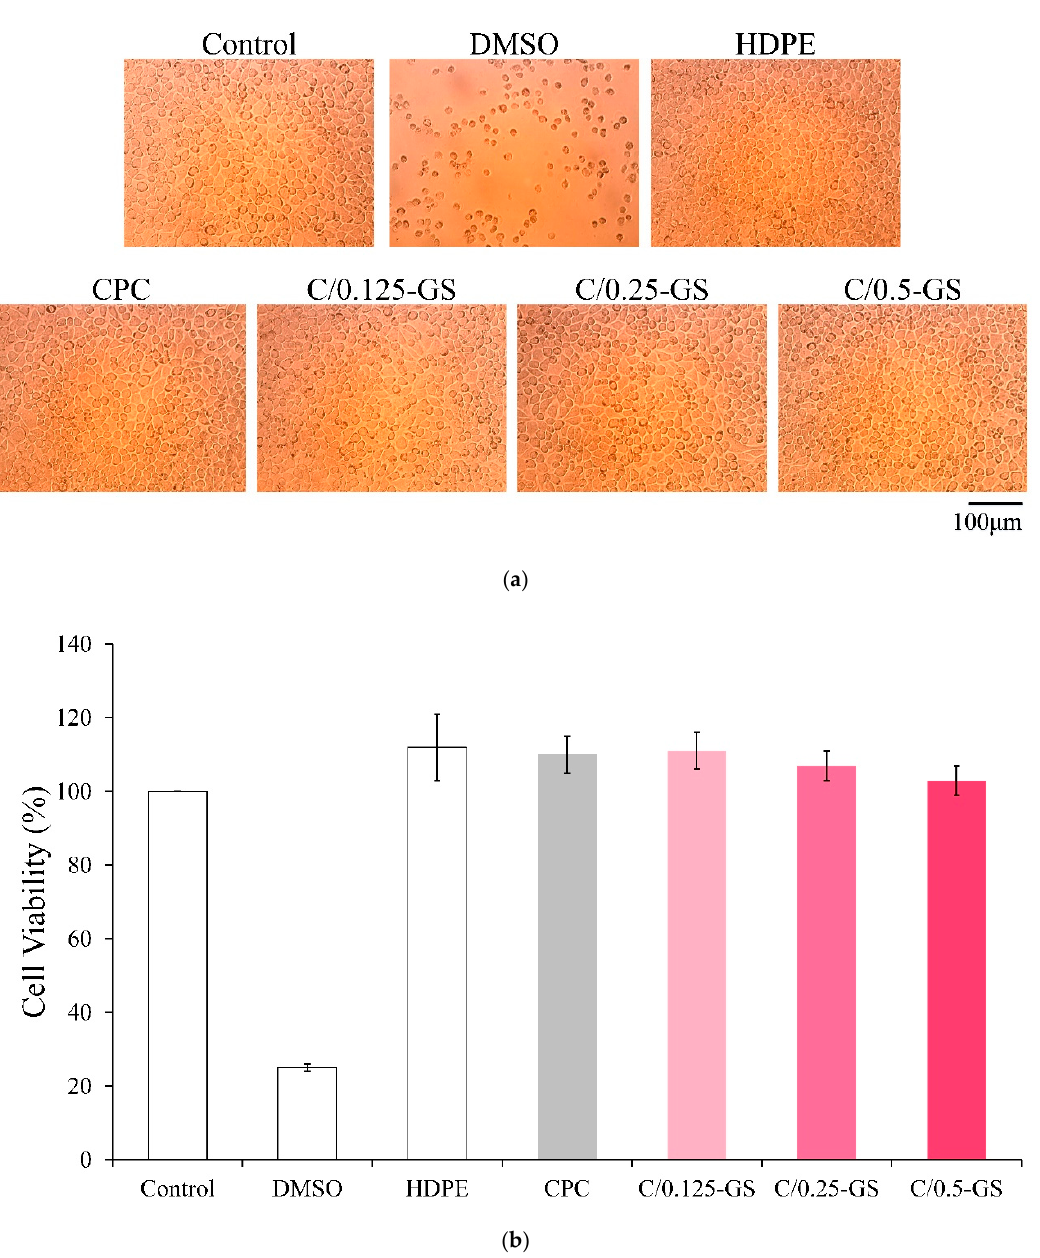
Figure 9. ( a ) Qualitative and ( b ) quantitative ( n = 5) analyses of the cytotoxicity of different CPC/hydrogels with gentamicin on L929 cells.